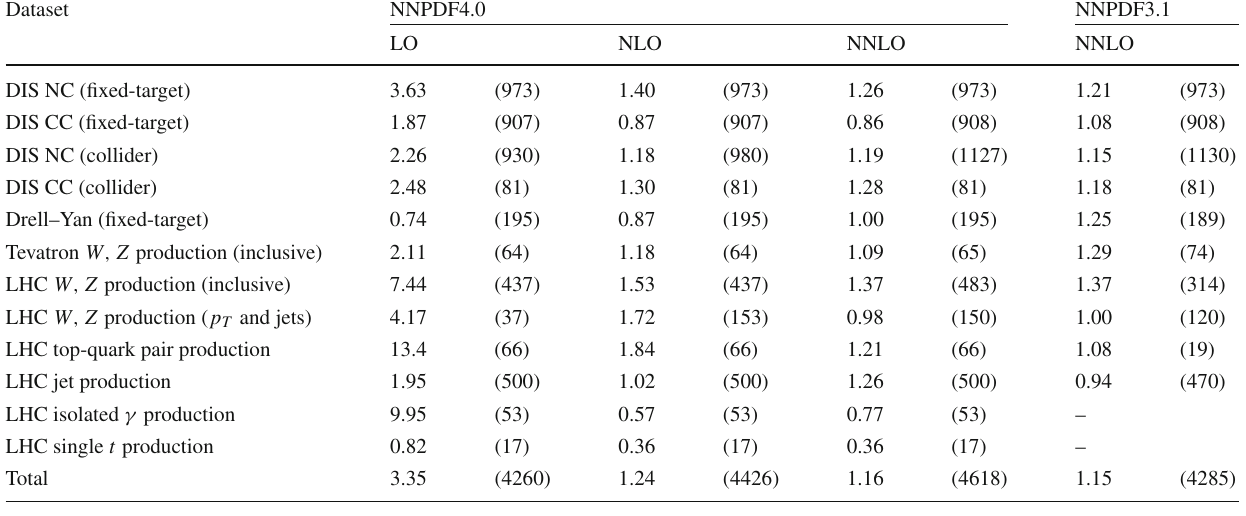
Table 19 Values of the χ 2 for each individual experiment included in the NNPDF4.0 PDF determination at LO, NLO, and NNLO; NNPDF3.1 NNLO is also shown for comparison. A dash denotes that the dataset was not included in the specific